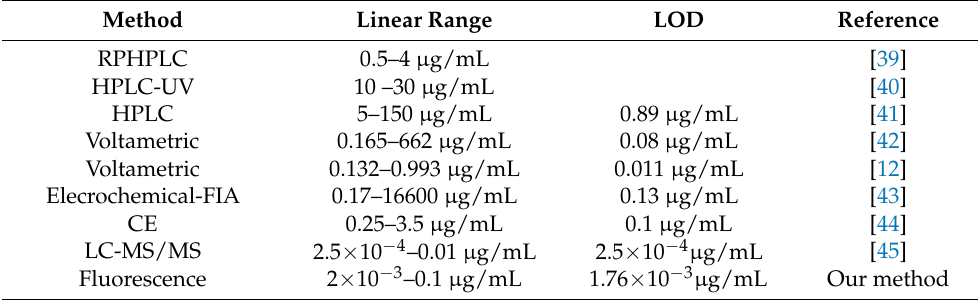
Table 1. Results of MFH detection using our method and previously reported methods.